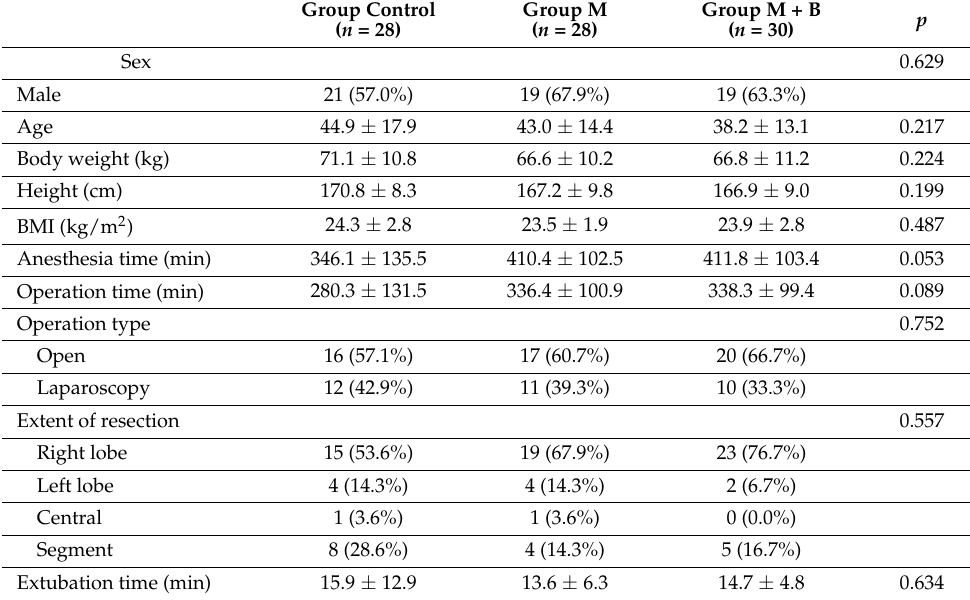
Table 1. Demographic data and intraoperational characteristics .